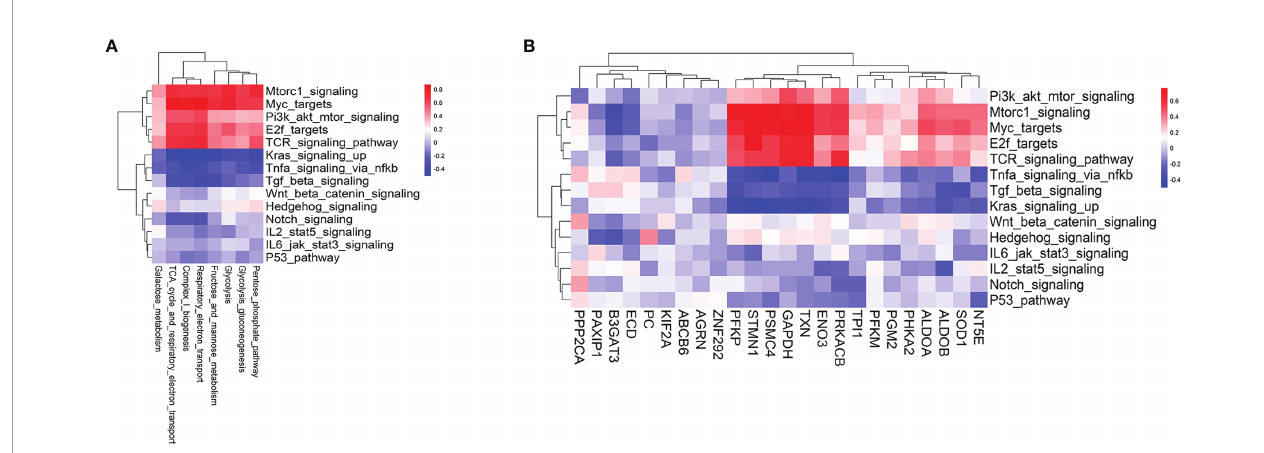
FIGURE 4 | Hallmark signaling pathways associated with glycolysis-related pathways and glycolytic genes. (A) Heatmap of the Pearson correlation coef fi cients between glycolysis-related metabolic signatures and hallmark as well as T-cell receptor (TCR) signaling pathways. (B) Heatmap of the Pearson correlation coef fi cients between glycolytic genes and hallmark as well as TCR signaling pathways. The hallmark signaling and TCR signaling gene sets are based on MSigDB.